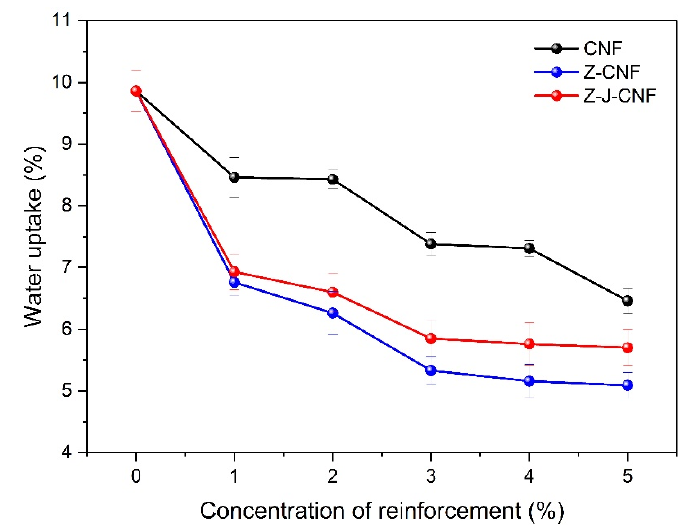
ff ects of CNF, Z-CNF, and Z-J-CNF content on water absorption of the Figure 11. Effects of CNF, Z-CNF, and Z-J-CNF content on water absorption of the films. Figure 11. E